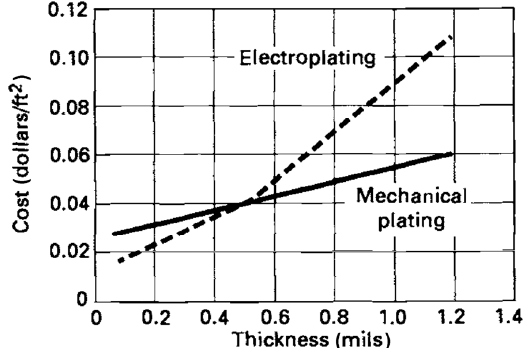
Fig. 4 Cost comparison of mechanical plating and electroplating in terms of chemicals used but not including labour or